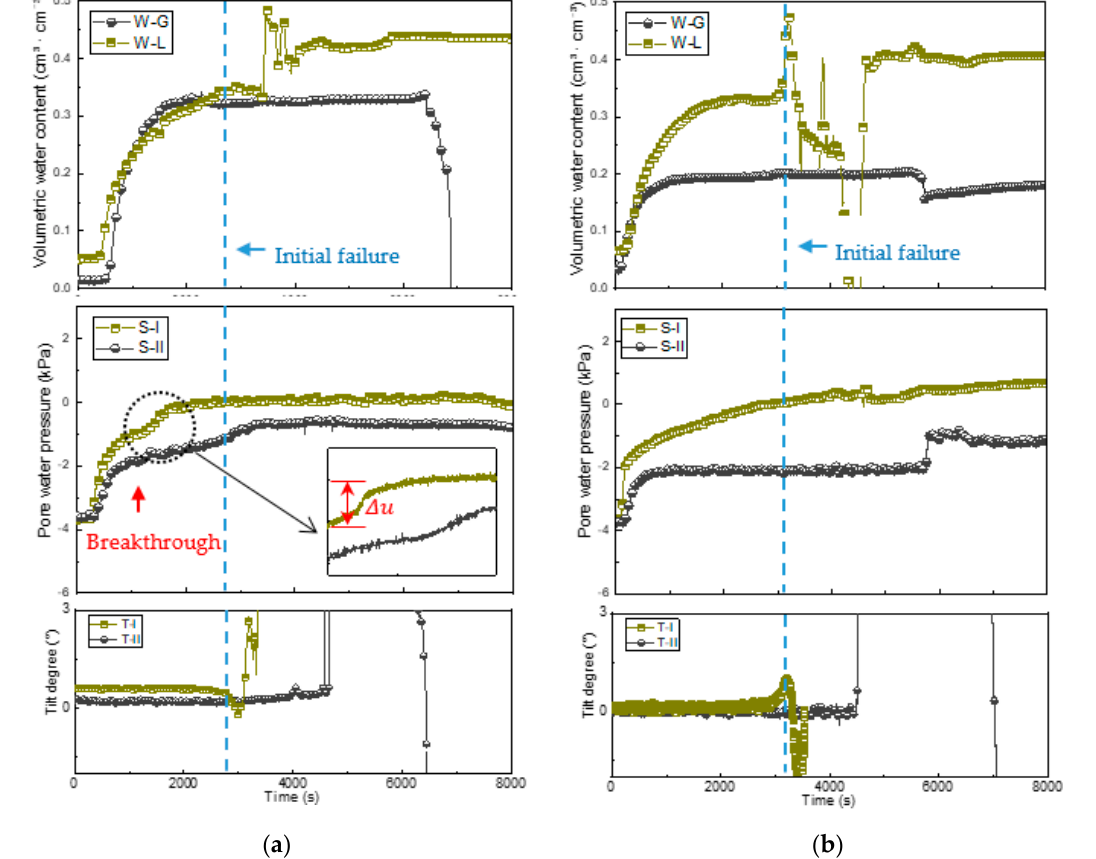
Figure 11. Volumetric water content, pore water pressure, and tilt angle change trends at different locations during infiltration. ( a ) Case III (tilt angle α = 15°, multi-layer), where the pore water pressure increased after capillary barrier breakthrough; ( b ) case VII (tilt angle α = 15°, single layer). For the positions of sensors, see Figure. 3b.